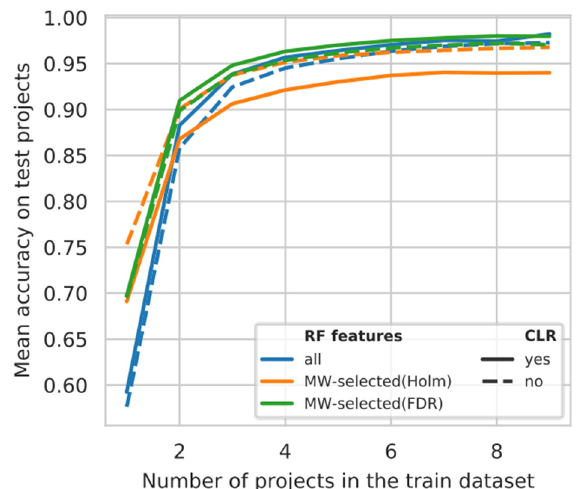
Figure 3. The dependency of accuracy on test human projects from the number of human projects used in the training set (for the genus models). The average value of accuracy among all the models (for the specific n ) and test projects is shown.